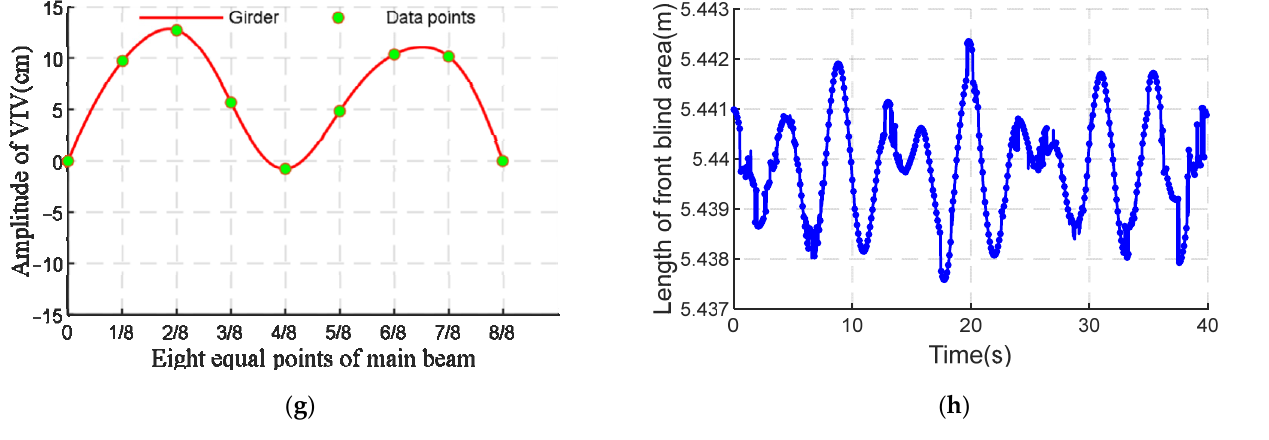
Figure 17. Online perception of front blind area for vehicles entering the bridge at different times. ( a ) When the peaks of the main beam are zero. ( b ) Online perception of front blind area. ( c ) When troughs of beams are the largest. ( d ) Online perception of front blind area. ( e ) When the trough of main girders is zero. ( f ) Online perception of front blind area. ( g ) When peaks of main girders are the largest. ( h ) Online perception of front blind area.